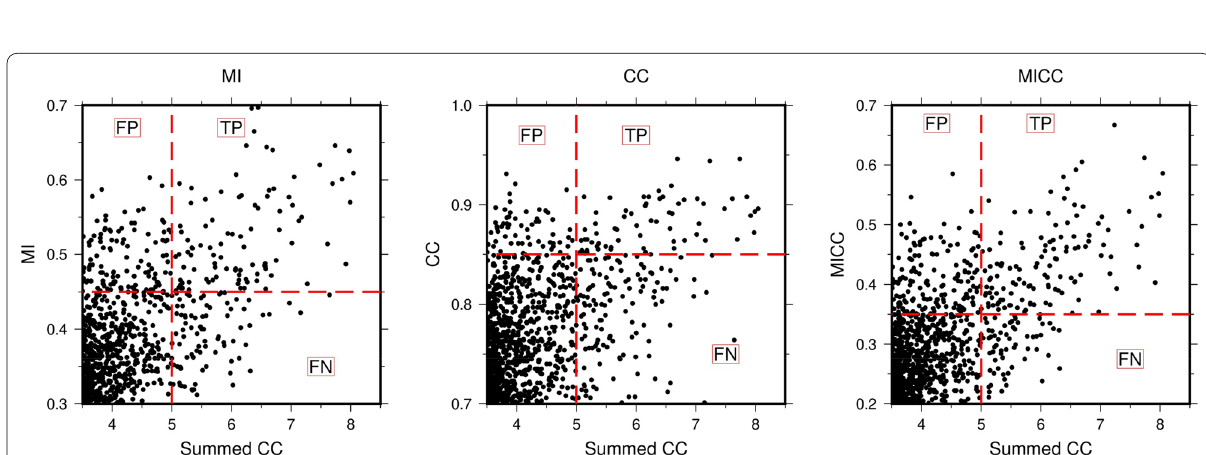
Fig. 13 Relations between summed CC (horizontal axis) and three indices (vertical axis) of a component of the data from N.SUKH station. Black dots correspond to each event. Red broken lines show the threshold of detection